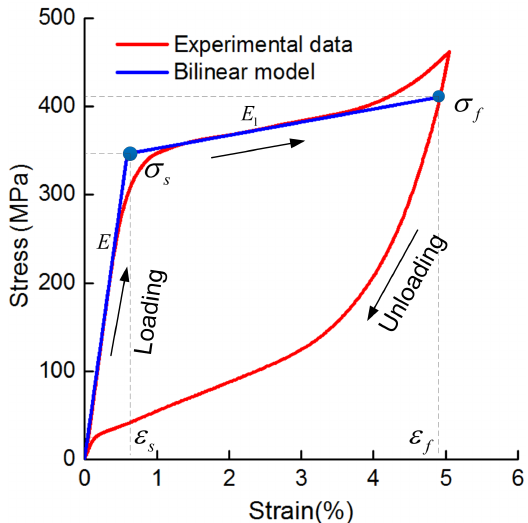
Figure 6. Experimental data of Nitinol uniaxial tensile behavior and the bilinear constitutive model.